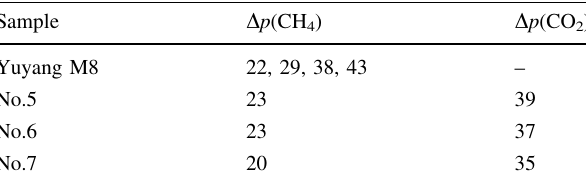
Fig. 13 The adsorption curves of M8 and No. 6 Table 6 Initial velocity of CH 4 and CO 2 diffusion of M8, No. 5–7 coal similar materials specimens